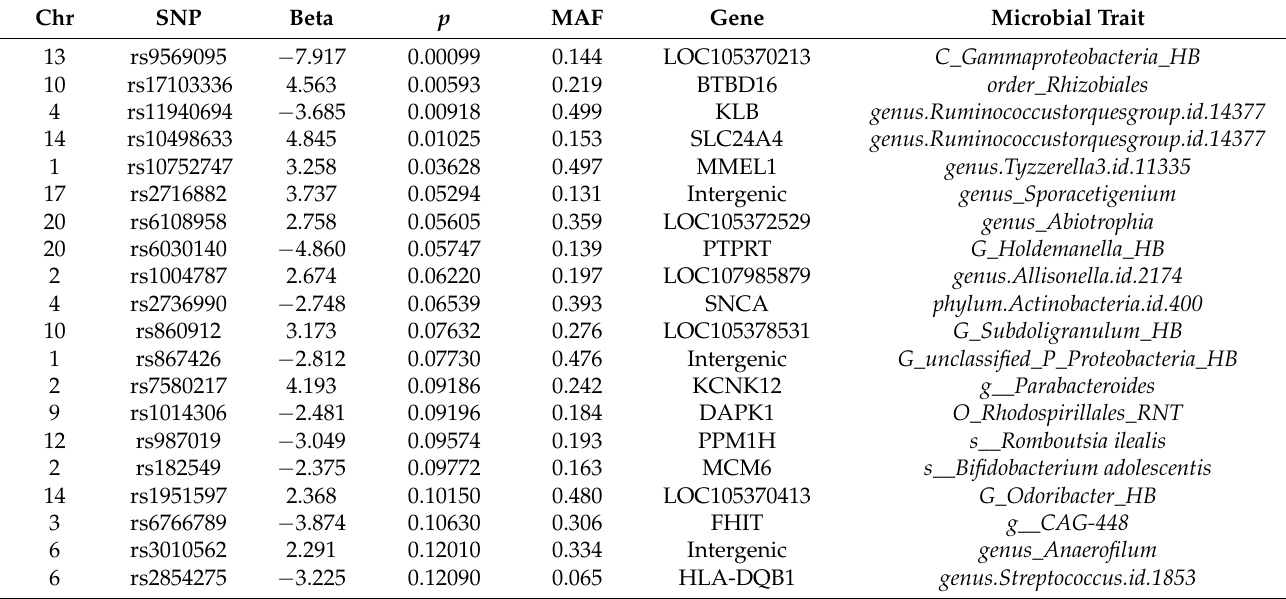
Table 2. Association between the top-ranked microbiota-related SNPs and fasting glucose in the whole population 1